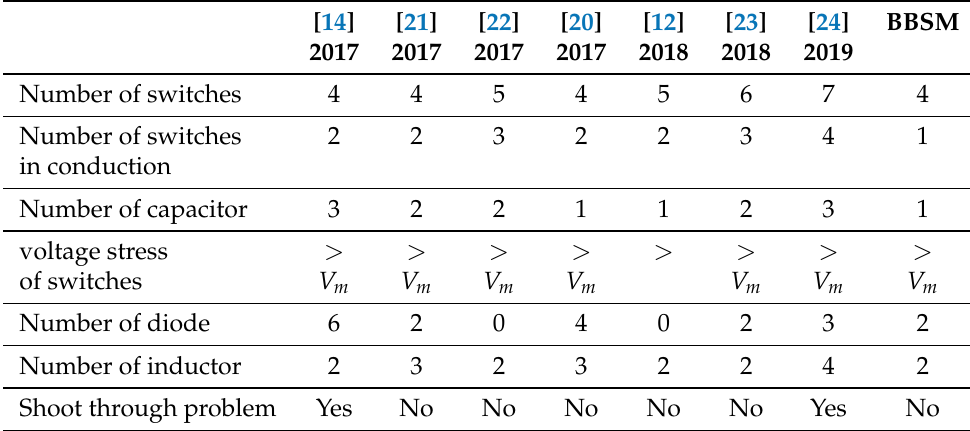
Table 8. Comparison of different topologies